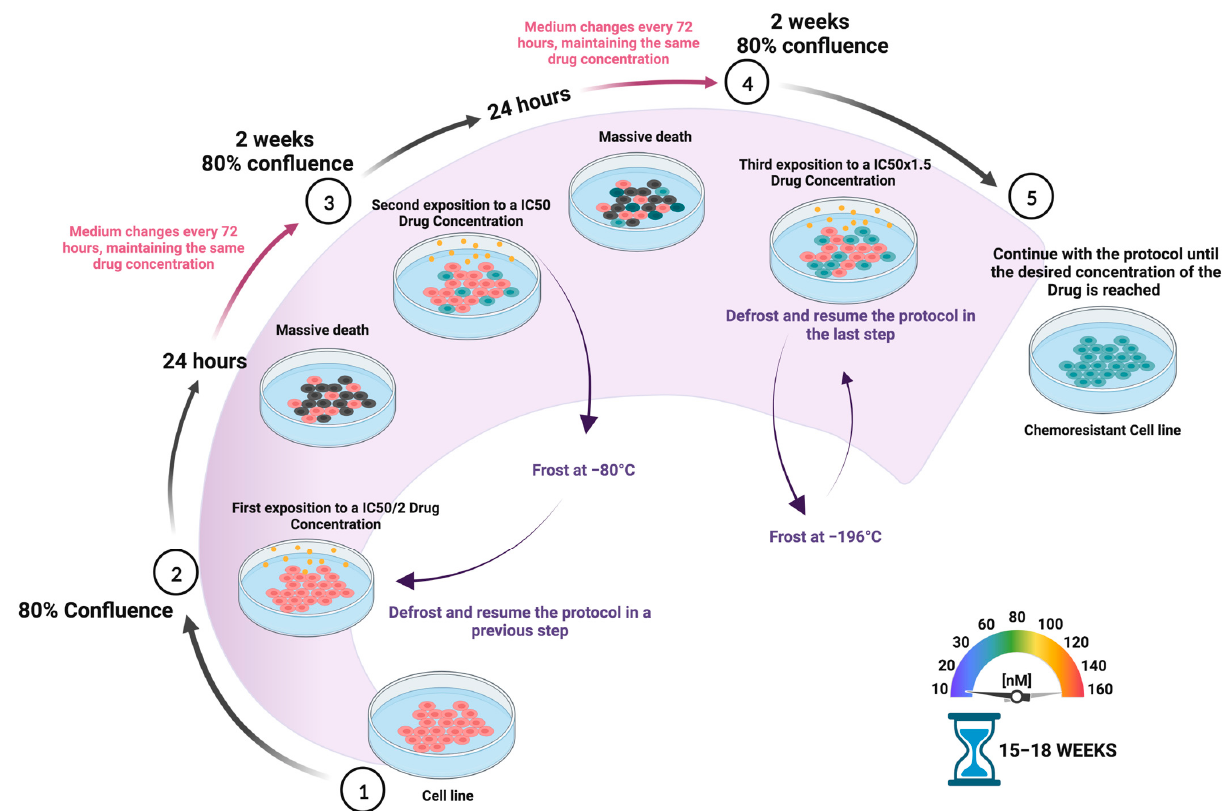
Figure 1. Schematic representation of the protocol used to develop drug-chemoresistant cell lines. To establish resistant tumor cell lines, increasing concentrations of the chemotherapeutical drug are periodically administered during a certain period of time, between 15 and 18 weeks, depending on the cell type. Briefly, cells are incubated with increasing concentrations of the drug in the culture medium from IC50/2 to the desired final concentration. The medium is changed every 72 h, while maintaining the drug concentration. Passage is done when cells acquire an 80% confluence